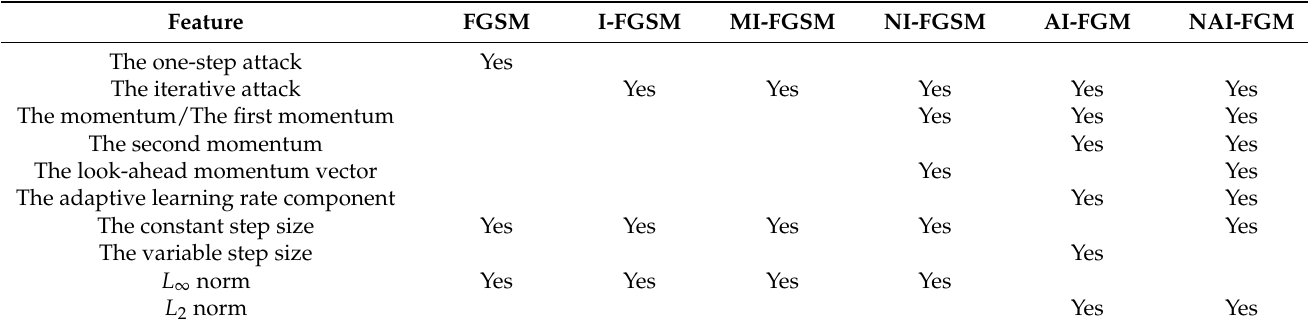
Table 1. The differences between gradient-based attacks.